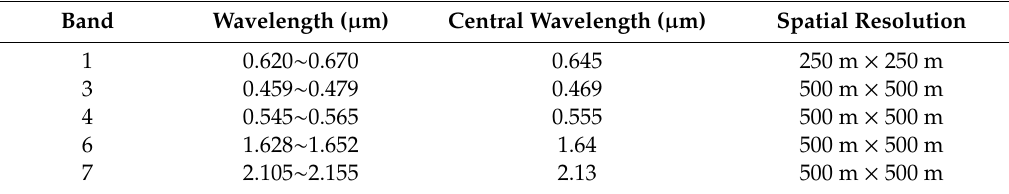
Table 2. Parameters of the chosen bands for dust storm detection from